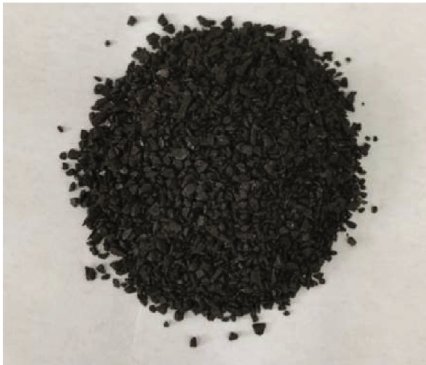
Figure 1: Experimental samples (coal particles with the sieving diameter of 1 ~